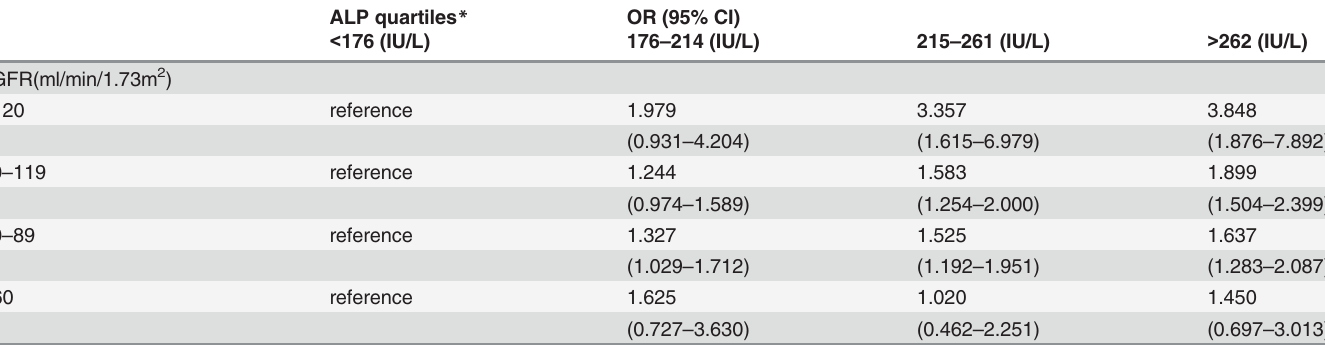
Table 2. Associations between serum alkaline phosphatase quartiles and metabolic syndrome according to the estimated glomerular filtration rate (eGFR).